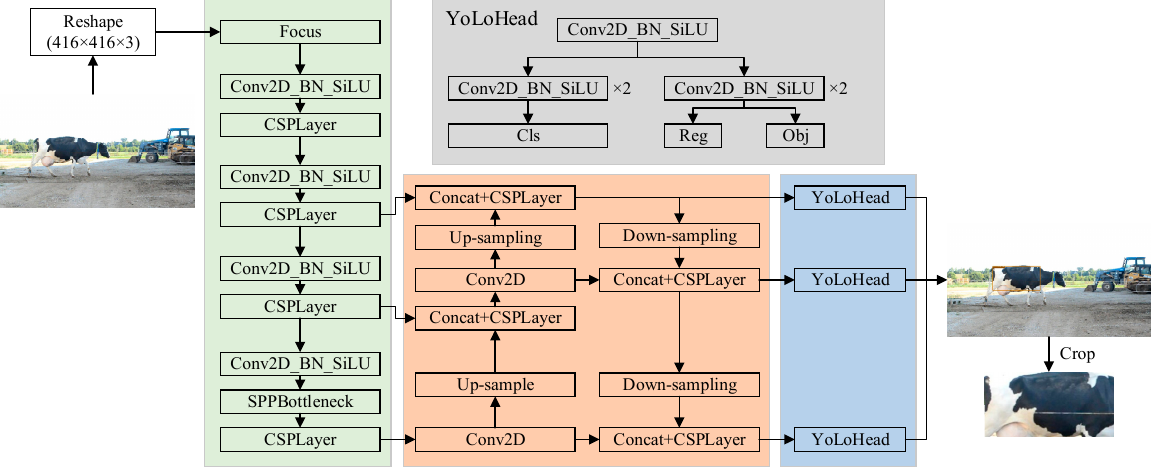
Figure 2. Acquisition of the cow body pattern image based on YOLOX.